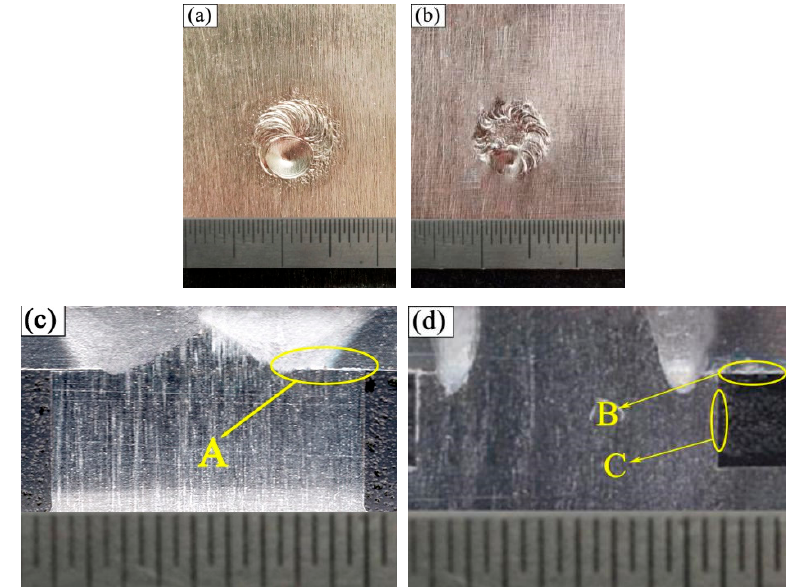
Figure 5. The morphologies and cross sections of the joints using different rivet. ( a ) the morphology of